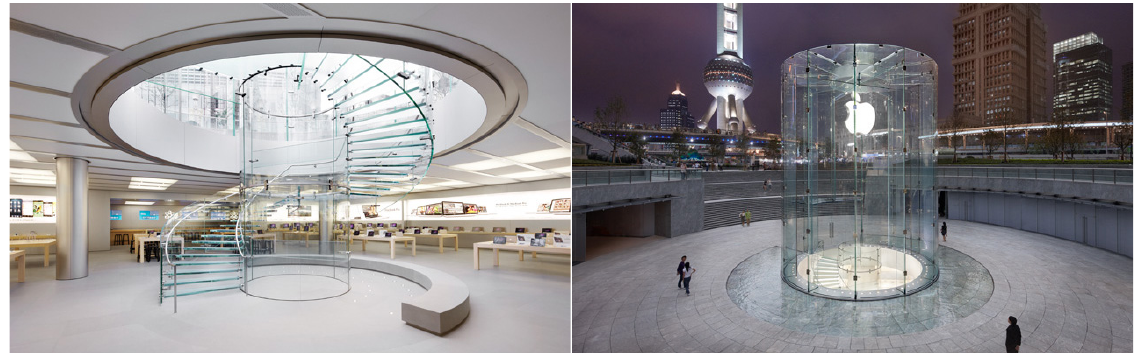
Fig. 1 Apple Store Shanghai (Porada